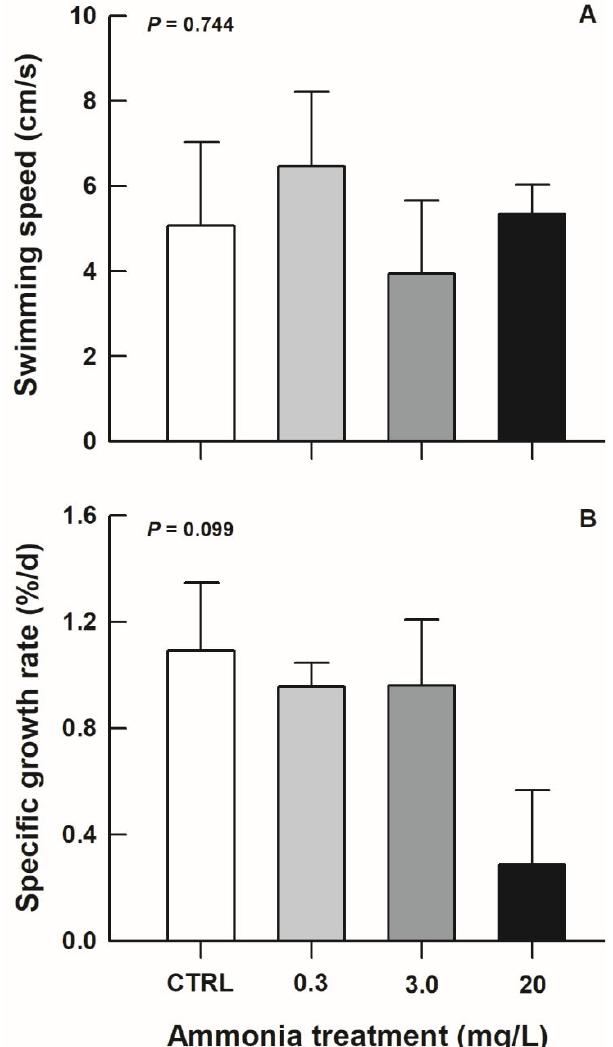
Figure 1. Swimming speed ( A ) and specific growth rate ( B ) of Trachemys scripta elegans juveniles exposed to CTRL, 0.3, 3.0, and 20 mg/L ammonia.